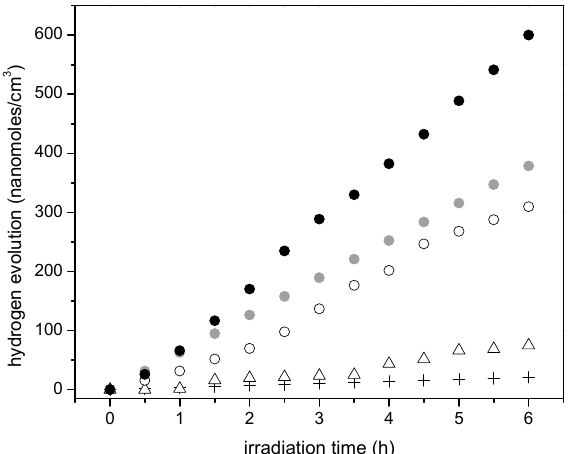
Figure 11. Cumulative hydrogen formation under an argon atmosphere for various photocatalysts using: ( ● ) ( ○ ) Pt–TiO 2 prepared via sol-gel B with 2.50 wt. % and 1.00 wt. % Pt, ( Δ ) Degussa P25, (+) Blank run [no photocatalyst]. Photoreaction conditions: pH = 4.00 ± 0.05, 2.00% v / v ethanol, photocatalyst loading: 0.15 g/L. Standard deviation for repeats was ±5%.